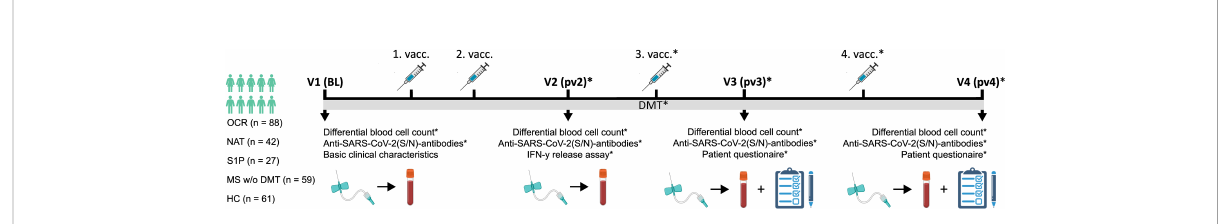
FIGURE 1 Study design illustrating patient cohorts and the time course of performed analyses. BL, baseline; DMT, disease modifying therapy; HC, controls without MS; IFN, interferon; Ig, immunoglobulin; MS, multiple sclerosis; N, nucleocapsid; NAT, natalizumab; OCR, ocrelizumab; pwMS, patients with MS; pv2/3/4, post second/third/fourth vaccination; S, spike; SARS-CoV-2, severe acute respiratory syndrome; S1P, sphingosine 1- phosphate receptor modulator; V, visit; vacc, vaccination; w/o, without. Created with